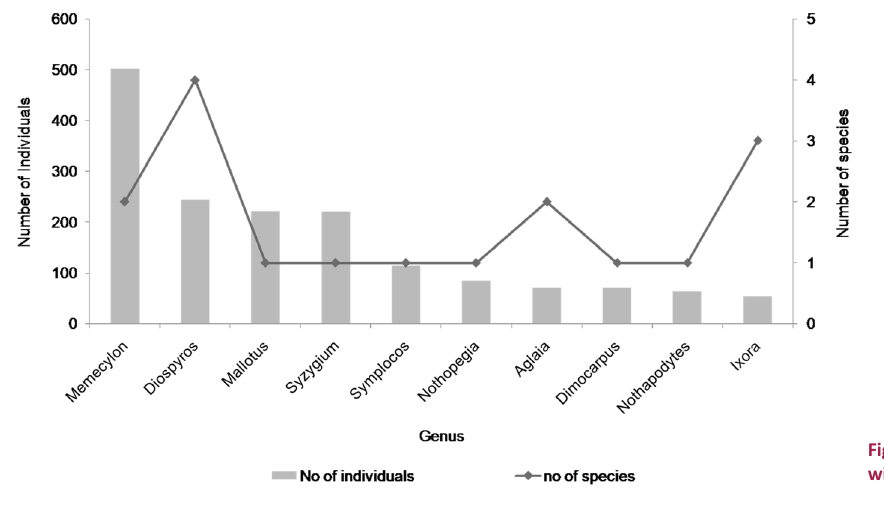
Figure 2. Ten most abundant genera with number of